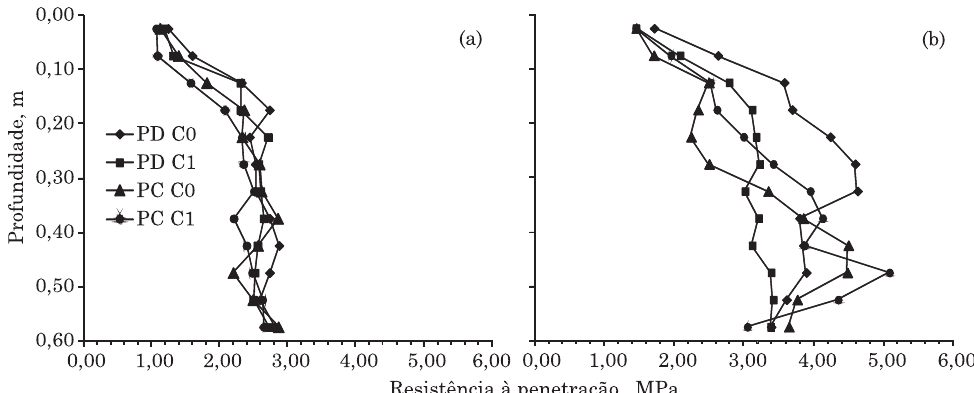
Figura 2. Valores da resistência à penetração por camada de solo nas posições linha (a) e entrelinha (b) na época de início do déficit hídrico (Época 4), nos tratamentos plantio direto (PD), plantio convencional (PC), sem calcário (C0) e com 2,0 t ha -1 de calcário (C1).